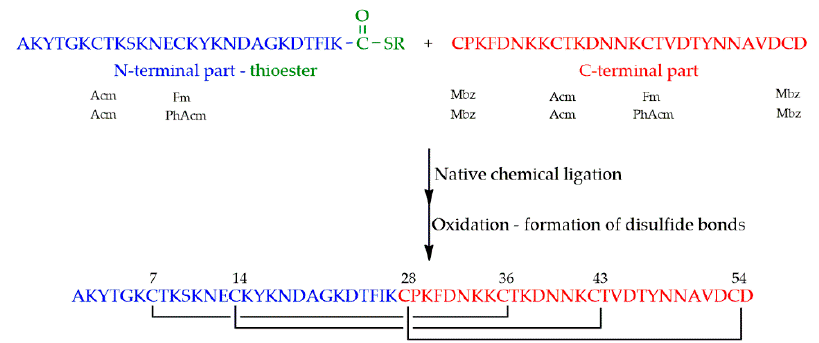
Figure 4. Synthesis of PAF by native chemical ligation and subsequent oxidation. (Thioester is symbolized by COSR). Orthogonal protecting groups of cysteines (shown below the sequences) were as follows: Acetamidomethyl (Acm), fluorenylmethoxycarbonyl (Fm), phenylacetamidomethyl (PhAcm) and methylbenzyl (Mbz).